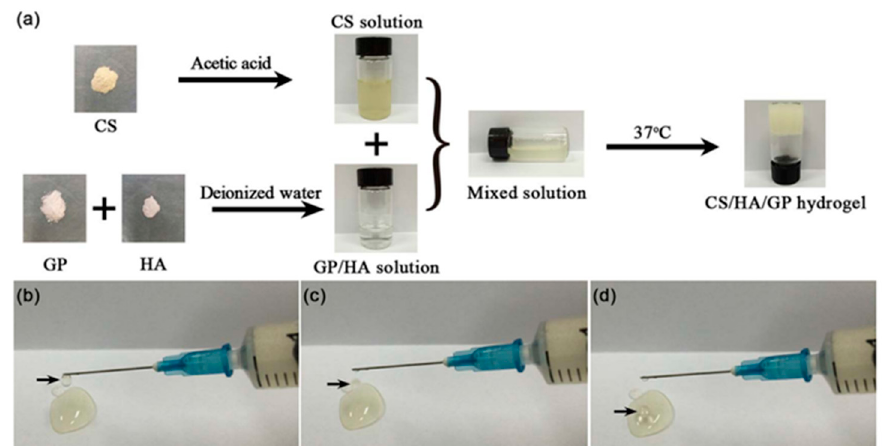
Figure 4. ( a ) The preparation of hydrogel precursor solution (HG3) and the solution at low temper- ature of 4 °C and the formed hydrogel at 37 °C, ( b – d ) the HG3 precursor solution can be readily ejected to form droplets using a syringe, adopted from [33] with permission from Elsevier through copyright clearance center. CS: Chitosan; HA: Hyaluronic acid; GP: Glycerophosphate.